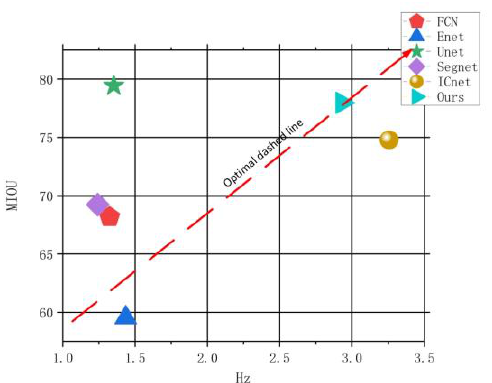
Figure 12. Comparison of accuracy and efficiency of different segmentation algorithms.